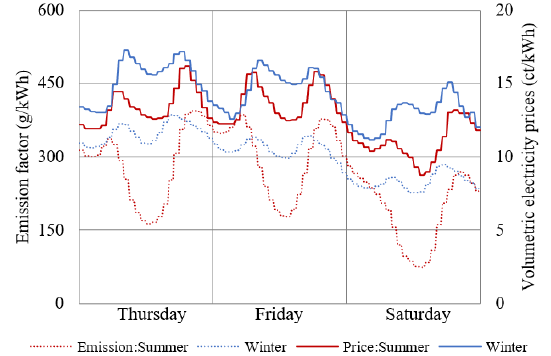
Figure 5. Average volumetric electricity prices and emission factor in summer and